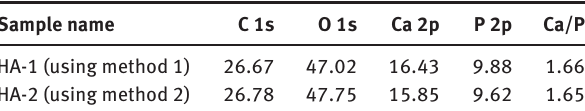
Table 2: Quantitative analysis of as-prepared hydroxyapatite samples by using X-ray photoelectron spectroscopy: relative chemi- cal compositions (atomic %).